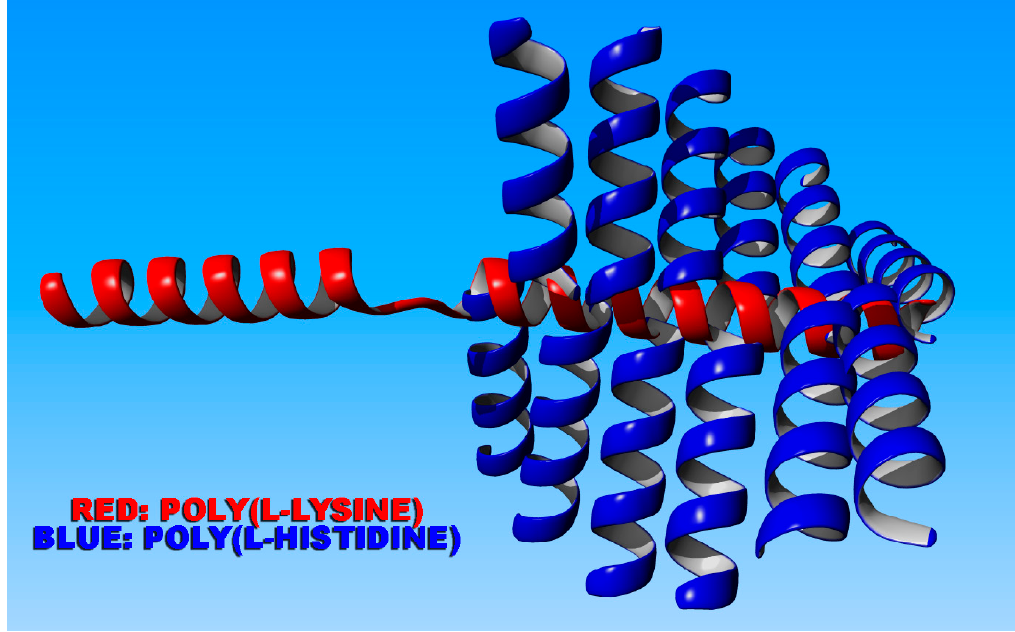
Scheme 8. The structure of the block-graft copolypeptide.